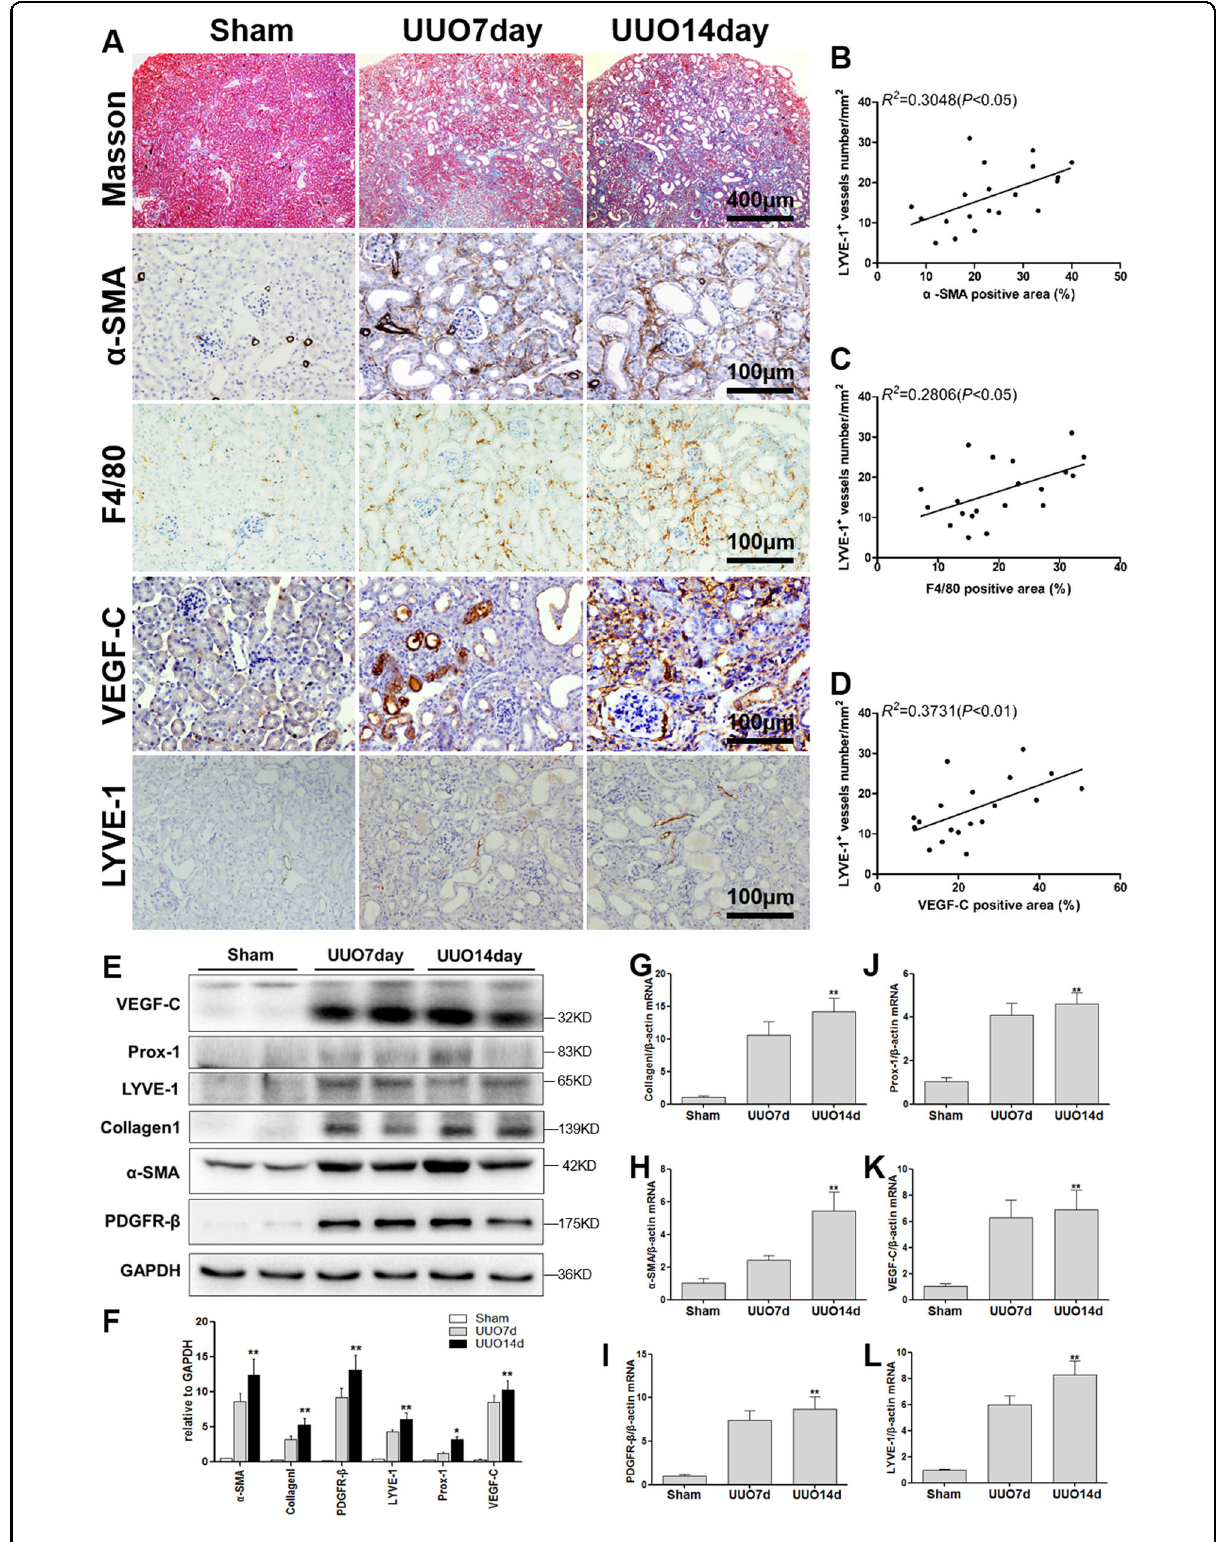
Fig. 1 (See legend on next